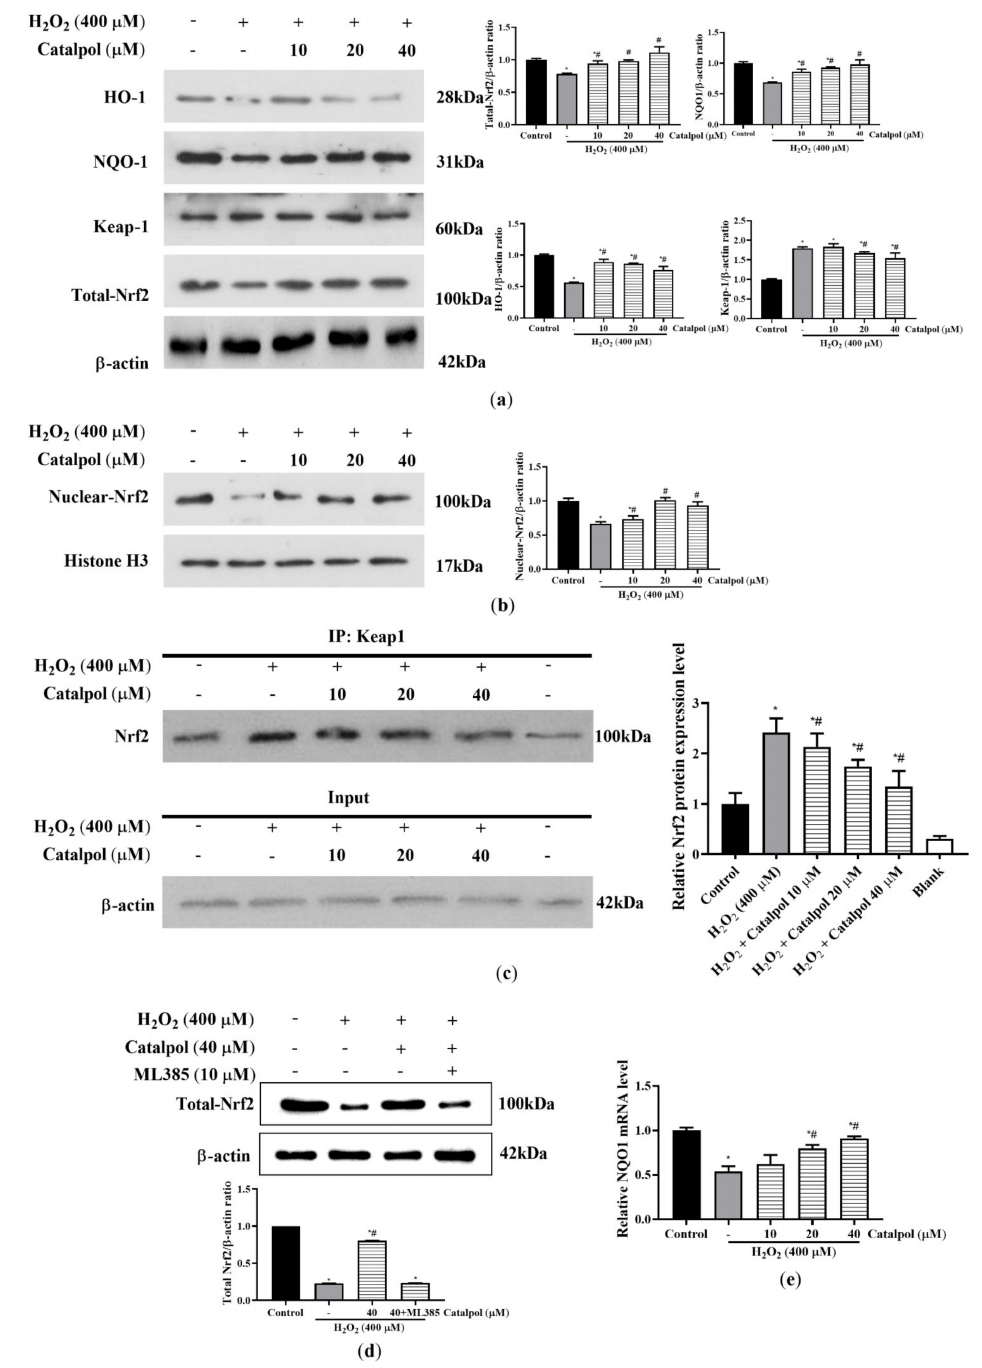
Figure 7. Catalpol activated Keap1/Nrf2/ARE pathway in H 2 O 2 -treated RPE cells. ( a and b ) ARPE-19 cells were pretreated with or without catalpol (10, 20 and 40 µ M) for 24 h, and then treated with 400 µ M H 2 O 2 for 6 h. The expressions of HO-1, NQO1, Keap1, Total-Nrf2 and Nuclear-Nrf2 were measured with Western blot assay. Histone H3 was used as an internal control for nucleoprotein, while β -actin was used as an internal control for total protein. ( c ) The effect of catalpol on the formation of Keap1/Nrf2 complex was determined using co-immunoprecipitation assay. ( d ) Treatment with ML385, a Nrf2 inhibitor, blocked the antioxidant protective effects of catalpol on increases in the expression of Nrf2 protein in H 2 O 2 -treated ARPE-19 cells. ( e ) Changes in gene expression of NQO1 were assayed with qRT-PCR. Data are presented as mean ± S.D. of three independent experiments (* p < 0.05 vs. control group, # p < 0.05 vs. H 2 O 2 (400 µ M)-treated